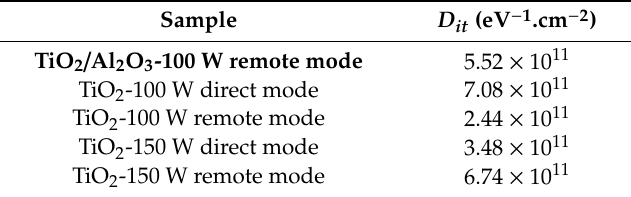
Table 3. Density of interface defects ( D it ) calculated by Hill–Coleman